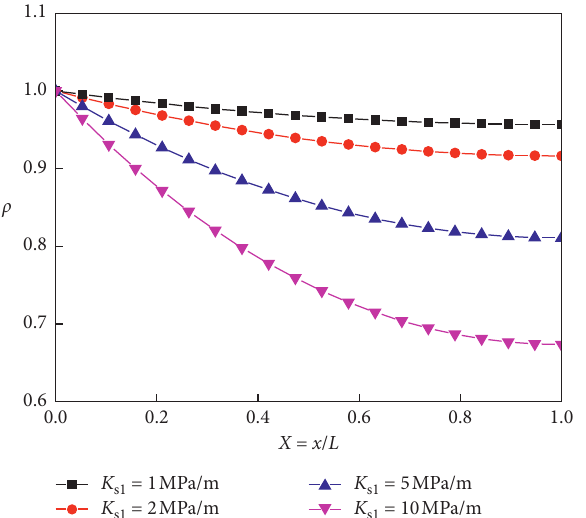
Figure 15: Effect of the interface frictional resistance at stage II on L p .